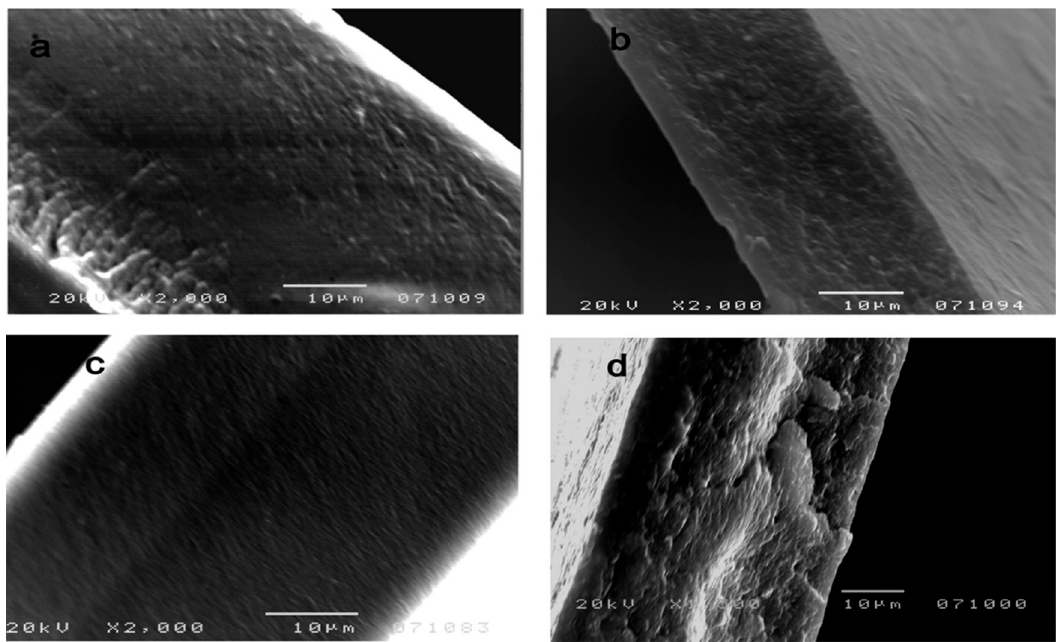
Figure 11. Scanning electron microscopy images of ( a ) uncrosslinked chitosan, ( b ) uncrosslinked chitosan–chitin nanocrystals composite, ( c ) crosslinked chitosan and ( d ) crosslinked chitosan–chitin nanocrystals [73].